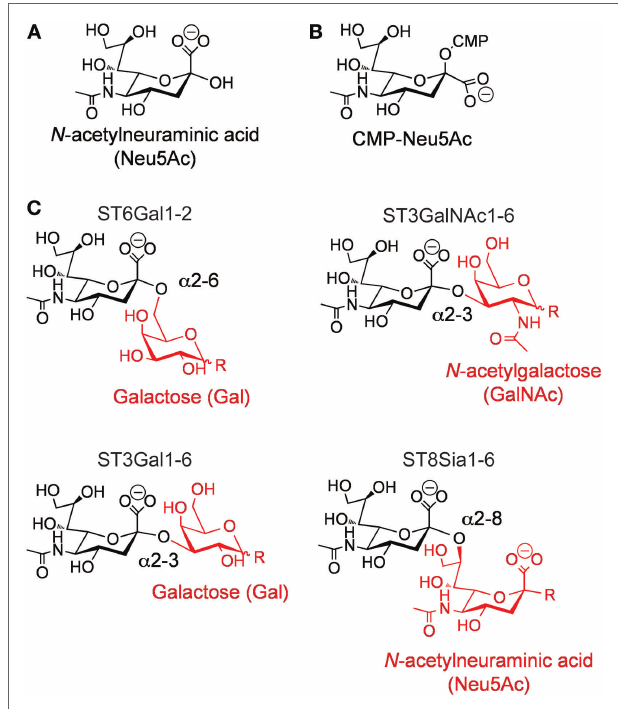
FiGURe 1 | (A) Structure of N -acetylneuraminic acid. (B) Structure of cytidine-5 ′ -monophospho-(CMP)-sialic acid. (C) Types of sialic acid linkages catalyzed by the different members of the mammalian ST family.